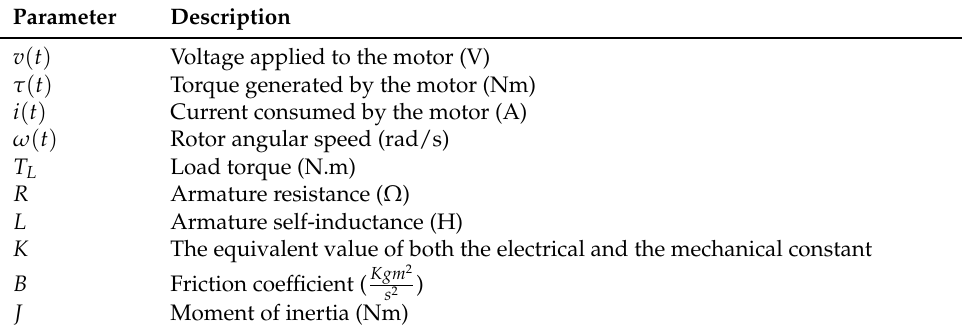
Table 2. Variables involved in the mathematical model of the DC motor. Parameter